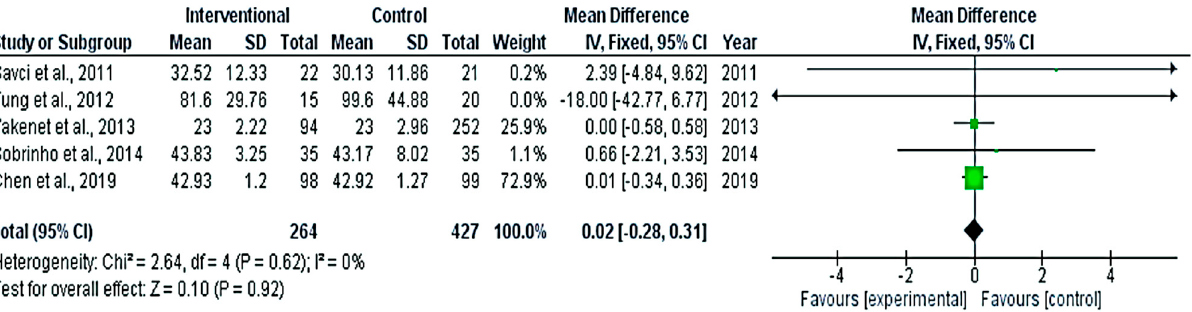
Figure 3. Forest plot evaluating ICU duration stay in the included studies.